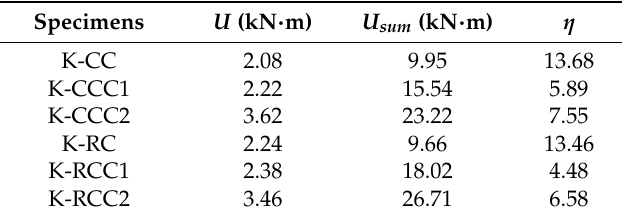
Table 4. Evaluation of energy